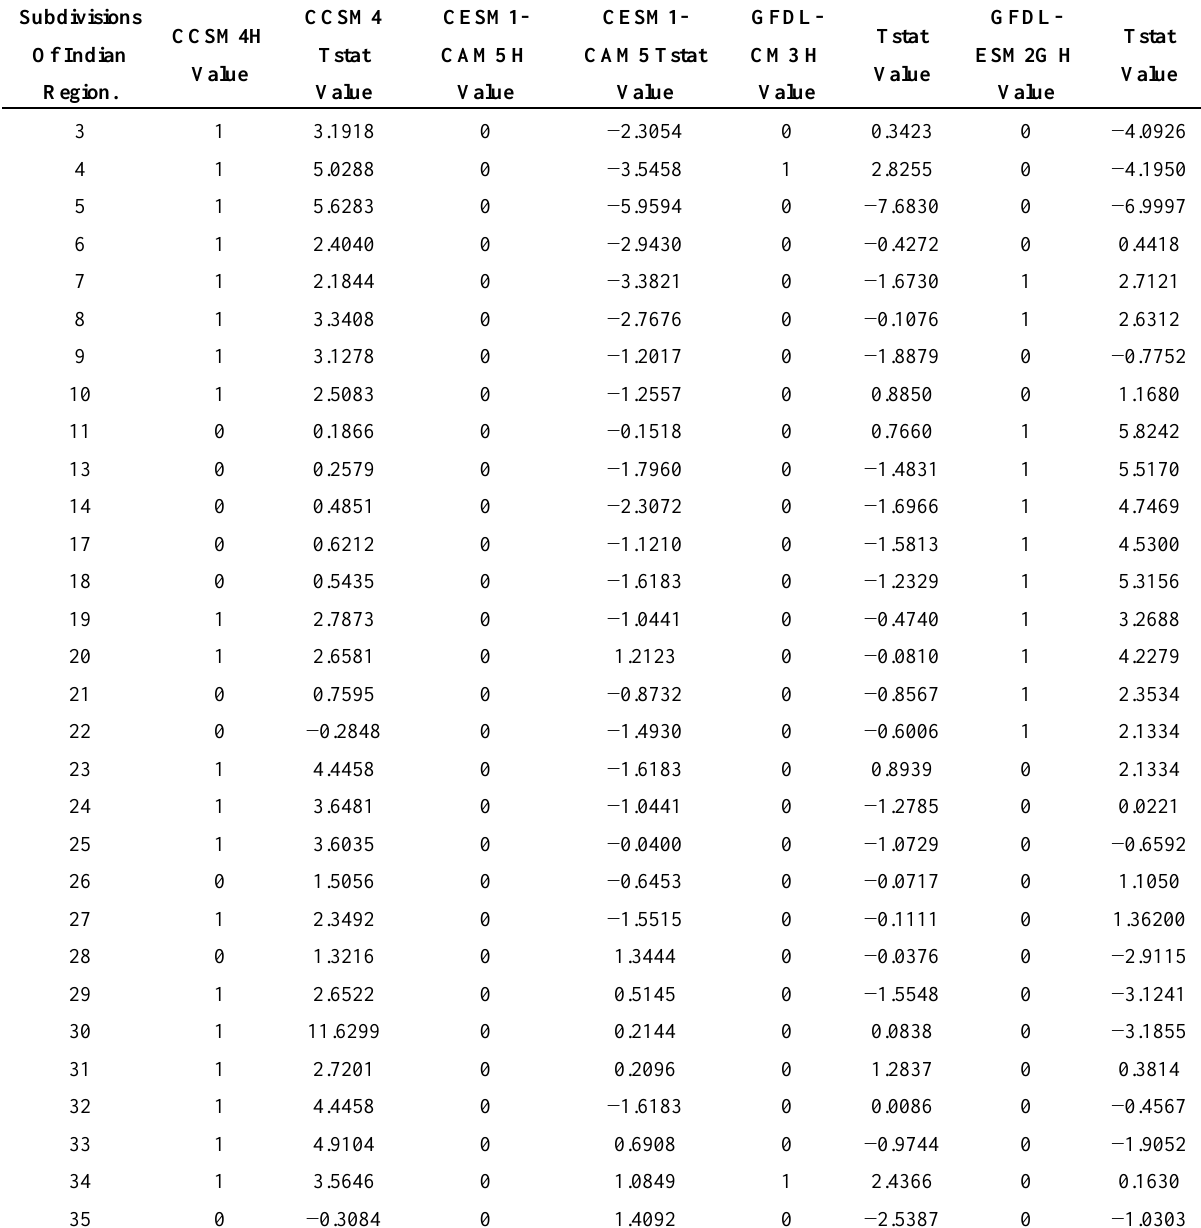
Table 4. Results of the t -test (the numbers in the first column represent meteorological subdivisions of the models mentioned in Figure